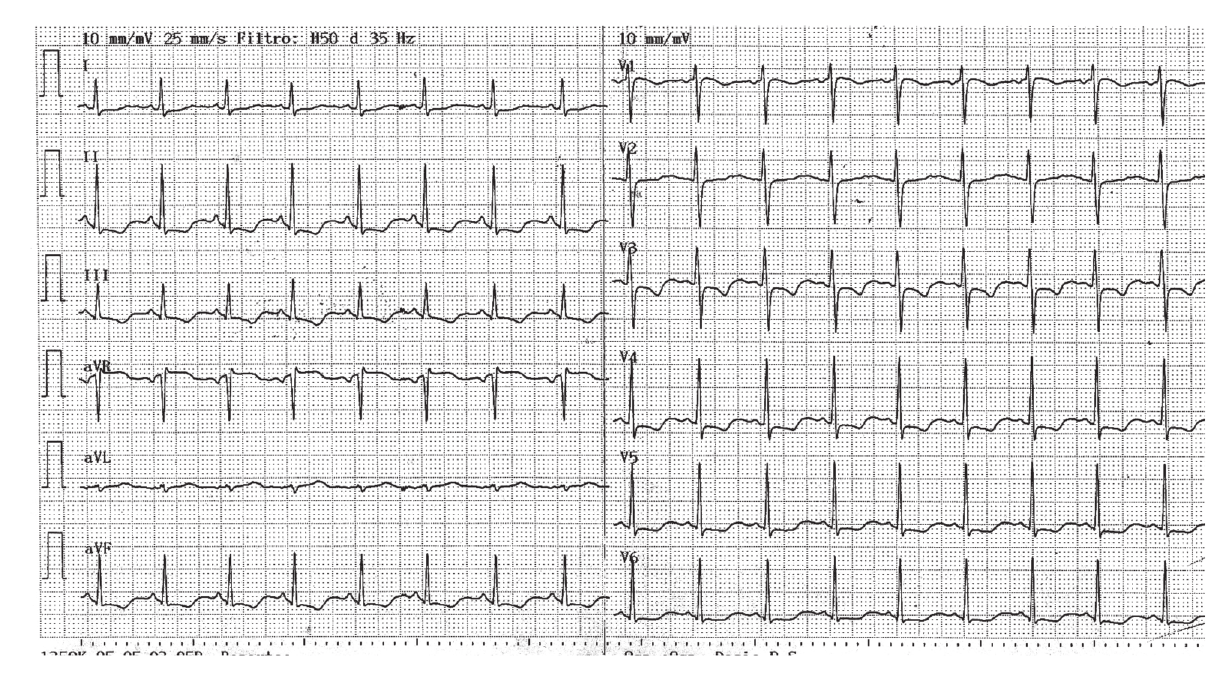
Figure 1. EKG showing ST depression in leads II, III, aVF, and